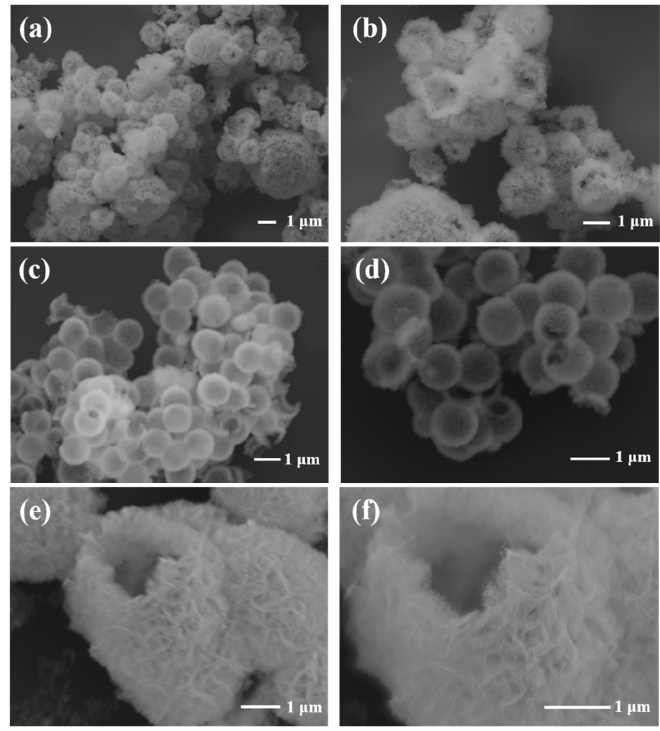
Figure 3. The SEM of ( a , b ) NiO-P; ( c , d ) NiO-N; ( e , f ) NiO-S.